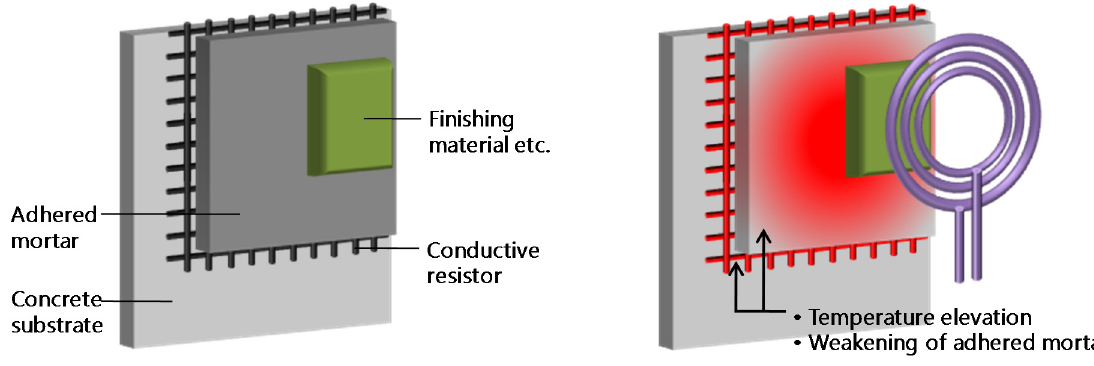
Figure 2. Separation model of finishing